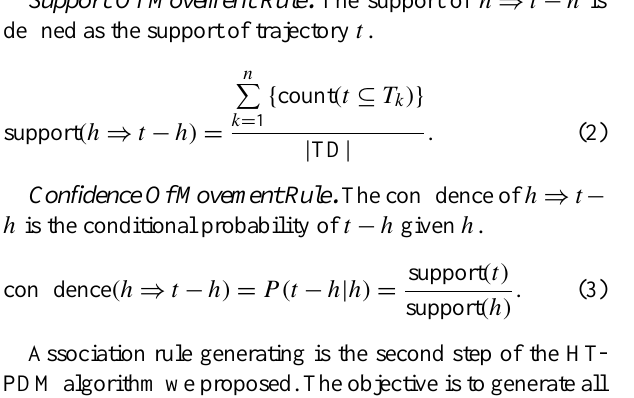
Table 1. Evaluation function’s